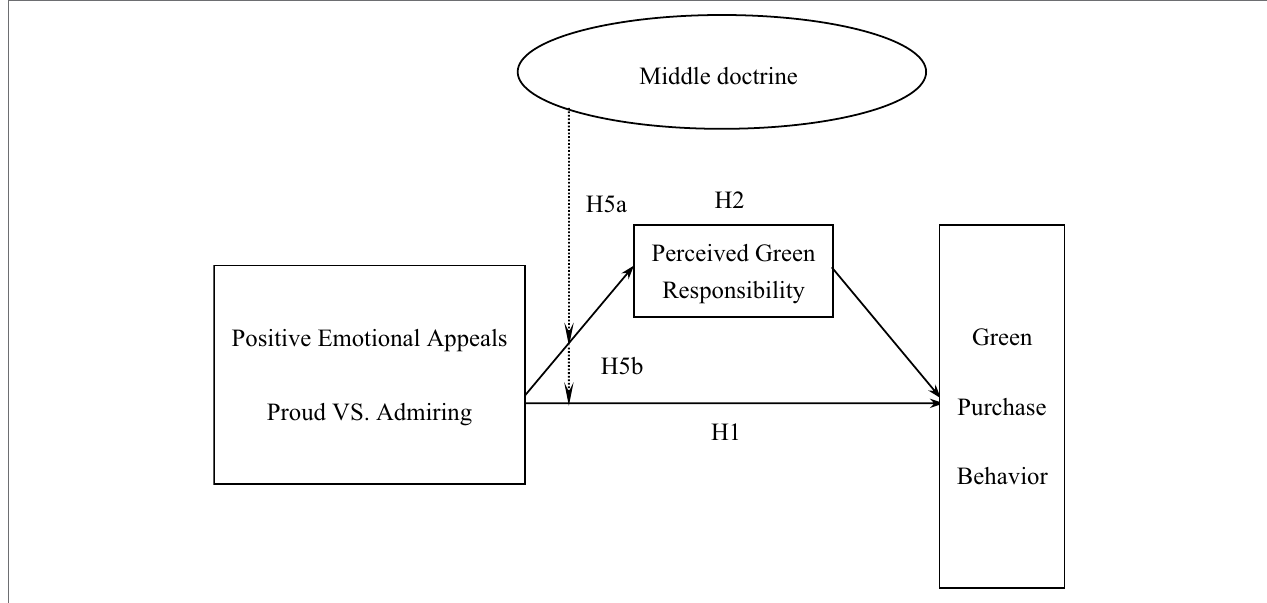
FIGURE 3 | Conceptual model of this study (dimensions of emotions toward the appropriate individual environmental behavior